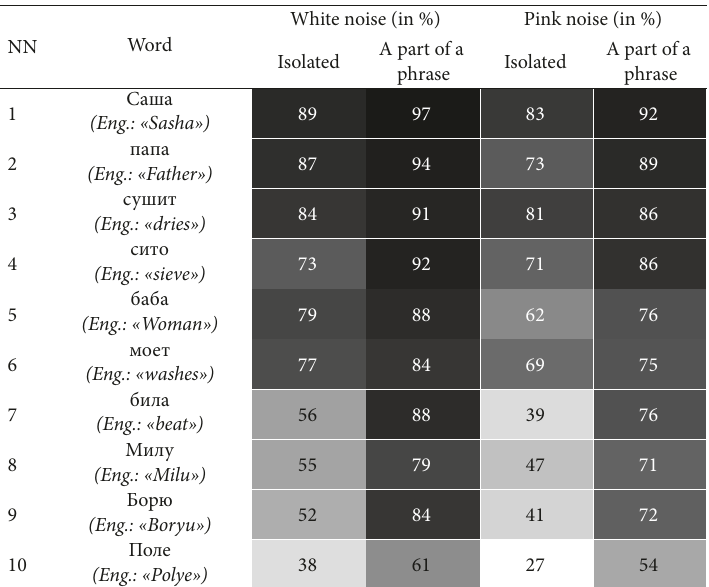
Figure 13: Comparative analysis of correct recognition of words in Russian against various types of noise in various context (isolated words or as a part of a phrase), in %.